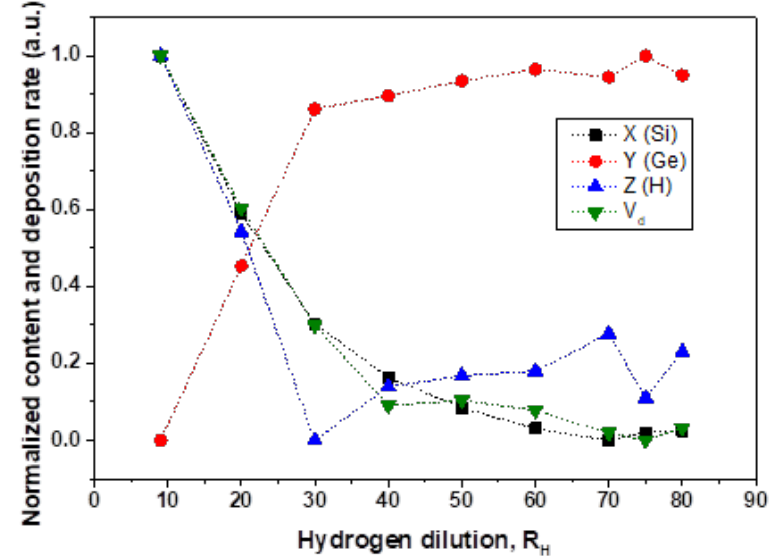
Figure 4. Normalized values for solid silicon, germanium, and hydrogen content and deposition rate of Si X Ge Y :H Z films as a function of hydrogen dilution ratio.